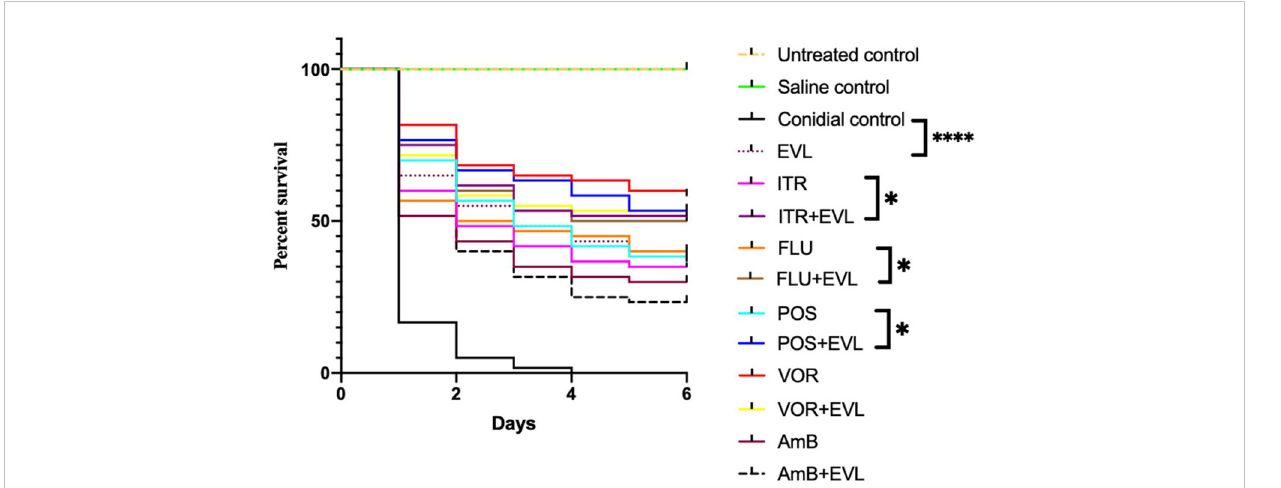
FIGURE 1 Galleria mellonella survival curves following infection with C.neoformans . Untreated group, noninfected larvae; Saline group, noninfected larvae injected with saline; Conidial group, C. neoforman -infected larvae without any treatment; POS, treatment of C. neoformans -infected larvae treated with posaconazole (POS) alone; POS+EVL, treatment of C. neoformans -infected larvae with POS and everolimus (EVL); ITR, treatment of C. neoformans -infected larvae with itraconazole alone; ITR+EVL, treatment of C.neoformans -infected larvae with ITR and EVL; VOR, treatment of C. neoformans - infected larvae with voriconazole alone; VOR+EVL, treatment of C. neoformans -infected larvae with VOR and EVL; FLU, treatment of C. neoformans -infected larvae with fl uconazole alone; FLU+EVL, treatment of C. neoformans -infected larvae with FLU and EVL; AmB, treatment of C. neoformans -infected larvae with amphotericin B alone; AmB+EVL, treatment of C. neoformans -infected larvae with AmB and EVL; EVL, treatment of C. neoformans -infected larvae with EVL alone (* p <0.05. **** p